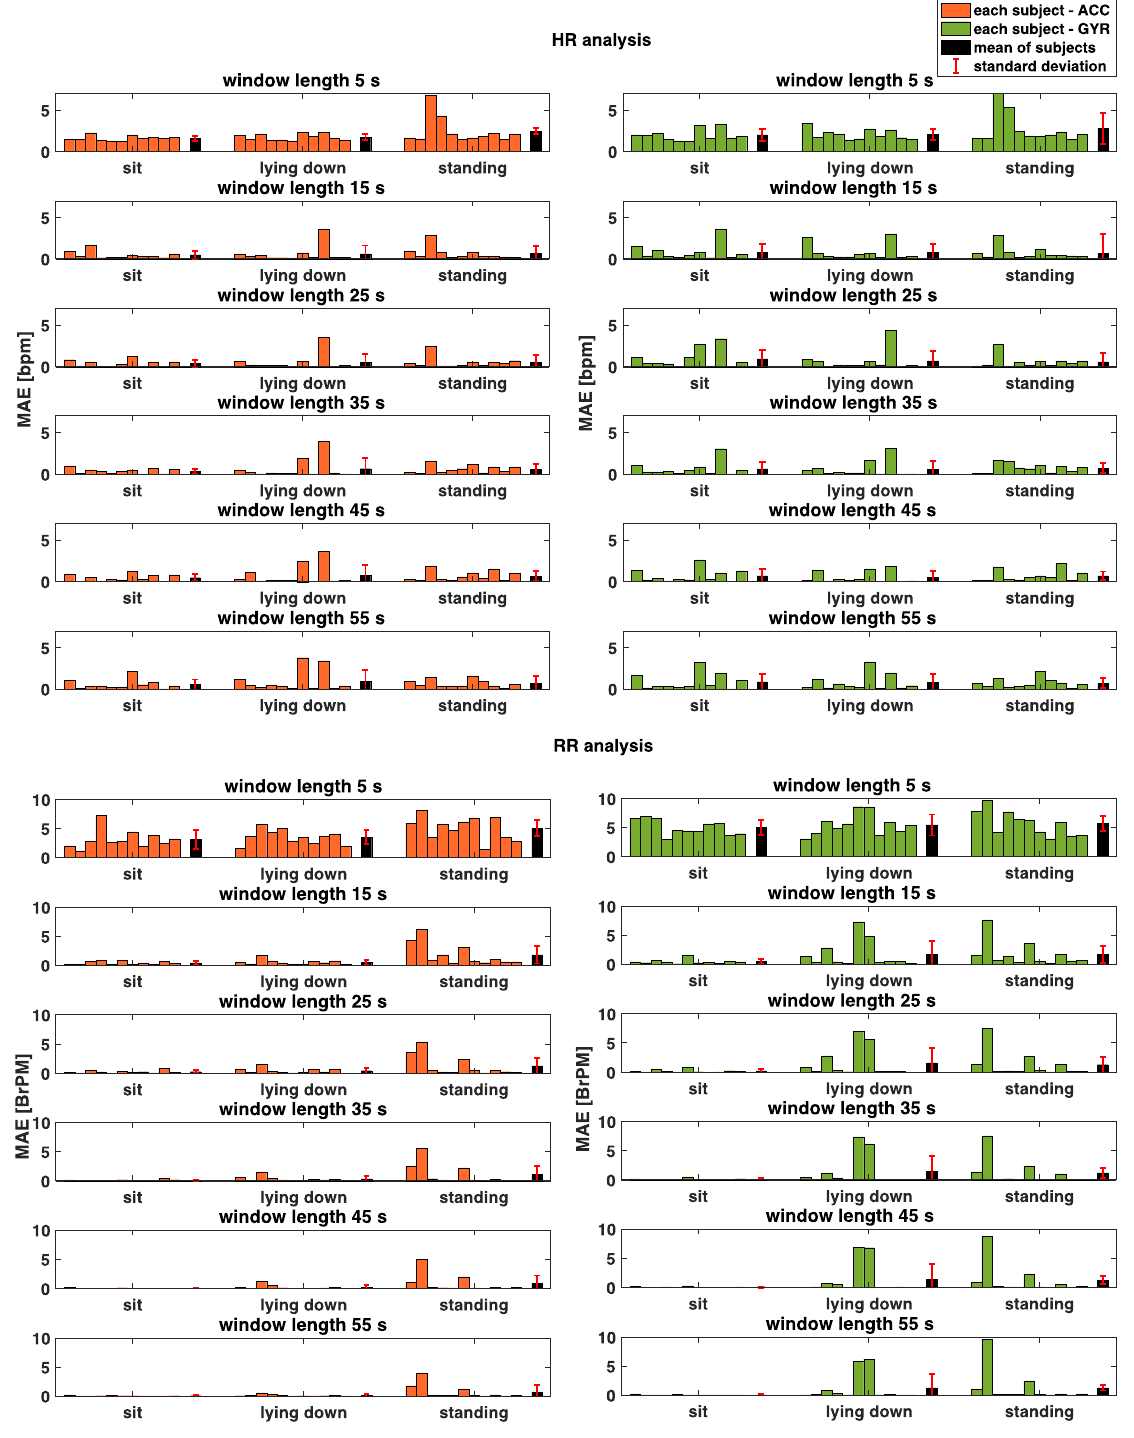
Figure 7. Bar graph of the mean absolute error (MAE) values calculated for both HR analysis (in the upper graph) and RR analysis (in the bottom graph) and for the ACC (in orange) and the GYR (in green). Moreover, these values are reported for each subject tacking on the different postures (i.e., sitting, lying down, and standing) and for all the window lengths. For each analyzed combination, we included the mean MAE value (in black) considering all subjects and the relative standard deviations (reported as an error bar in red).